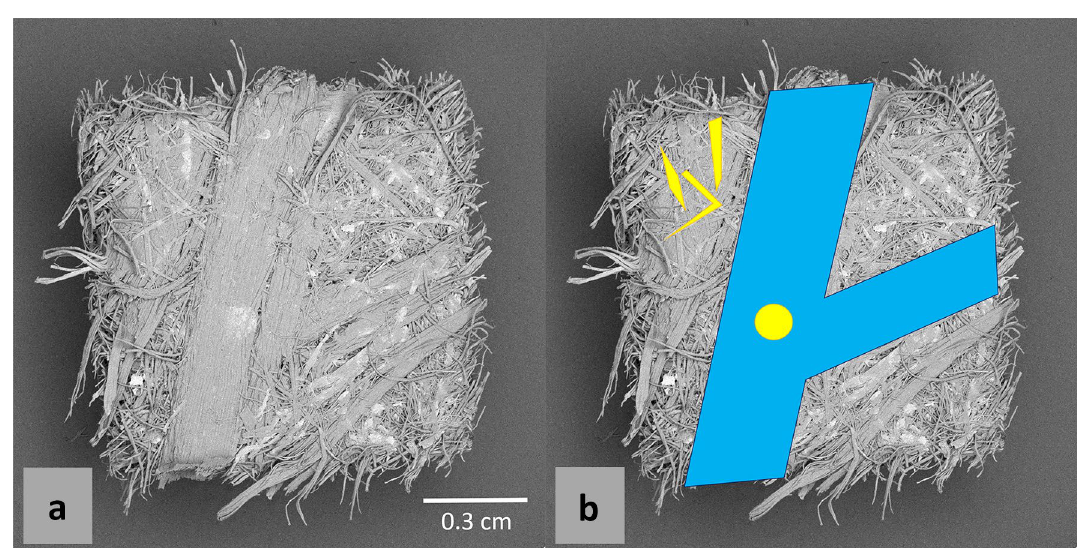
Figure 4. Scanning electron microscopy image of the sample’s surface, and primary feature schematics. ( a ) Original SEM image; ( b ) SEM image overlaid with the shapes of easily-identifiable features: in blue, two fiber bundles intersecting; in yellow, some important glue spots that can be related to Fig.